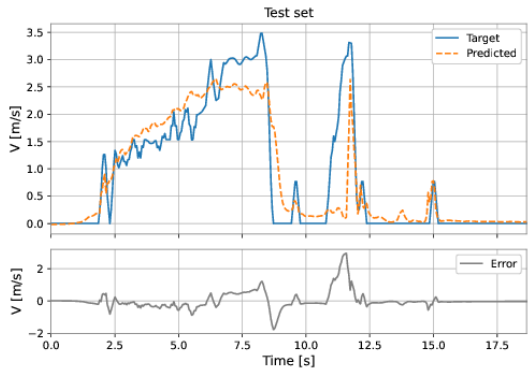
Figure 47. MLP’s predictions on the training set.